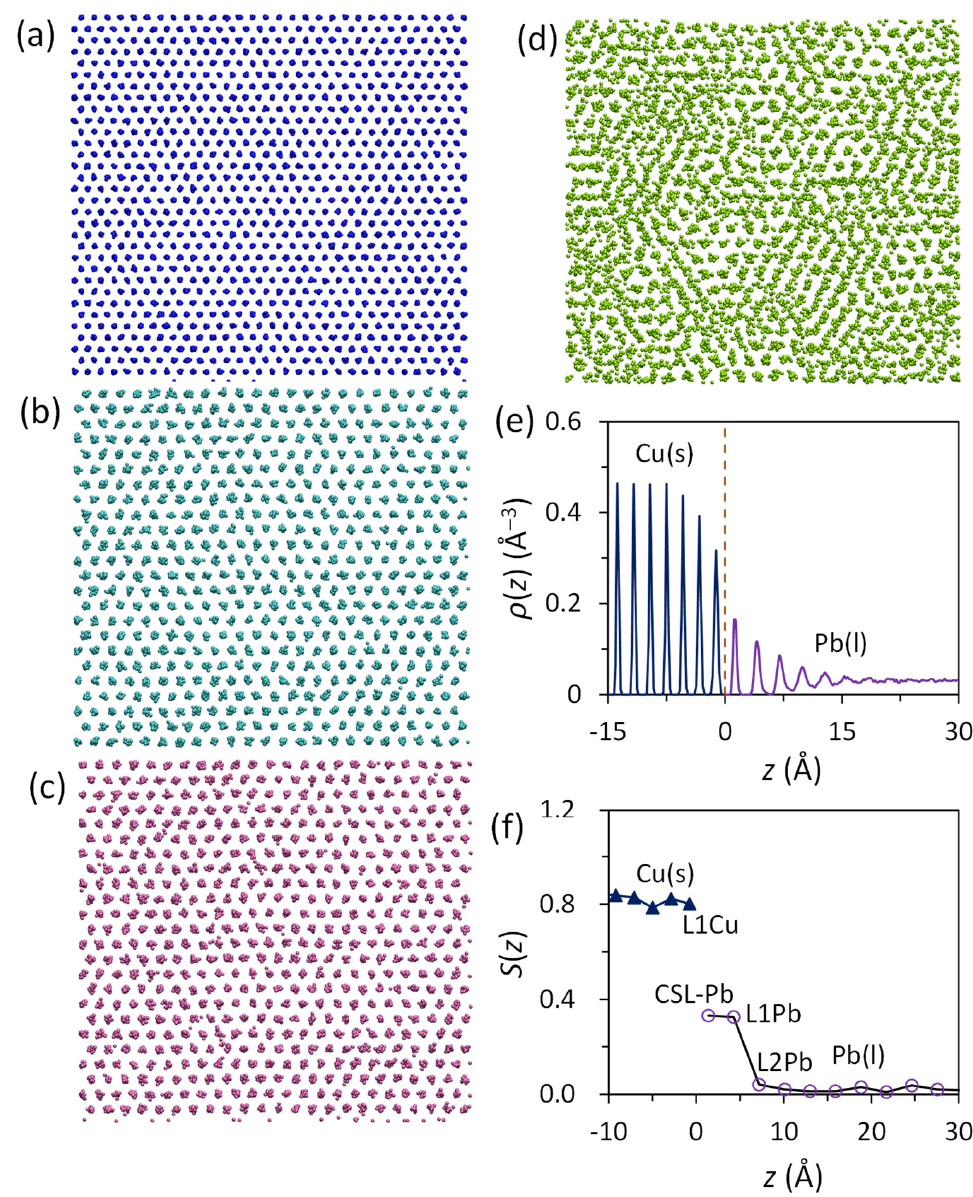
Figure 8. Prenucleation in systems with large positive misfit demonstrated by the Pb(l)/Cu(s) system [27]. Time-averaged atomic positions show the atomic arrangement of ( a ) the first Cu layer (L1Cu), ( b ) the CSL (coincidence site lattice) Pb layer; ( c ) first liquid Pb layer (L1Pb); and ( d ) the second liquid Pb layer (L2Pb) in the Pb(l)/Cu(s) system equilibrated at 625 K (above the melting temperature of Pb, 618 K). ( e , f ) show the ρ ( z ) and S ( z ) as a function of distance from the interface. There exists pronounced atomic ordering, including layering and in-plane atomic ordering, in the liquid Pb induced by the Cu substrate.